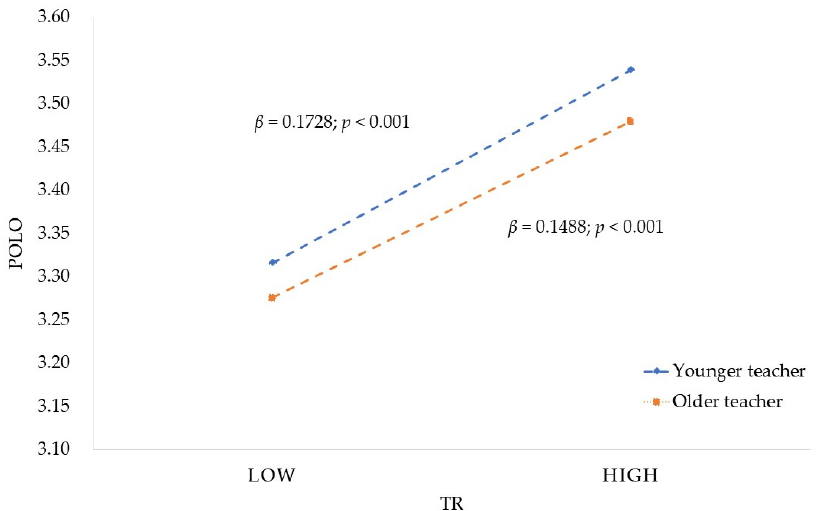
Figure 4. Moderating role of TA in the relationship between TR and POLO. (Source: drawn up by the authors).